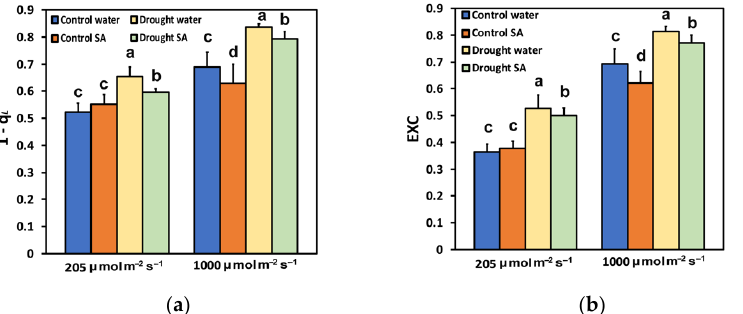
Figure 6. The fraction of closed PSII reaction centers (1- qL ), based on the “lake” model for the photosynthetic unit ( a ); and the excess excitation energy (EXC) ( b ); of oregano seedlings grown under optimal conditions (control) or moderate drought stress (MoDS) and sprayed with 1 mM SA or H 2 O. 1- qL and EXC were estimated at 205 (LL) or 1000 (HL) µ mol photons m –2 s –1 actinic light (AL) intensity. Error bars represent standard deviations ( n = 4). Different lowercase letters, within the same light treatment, represent statistical difference ( p <